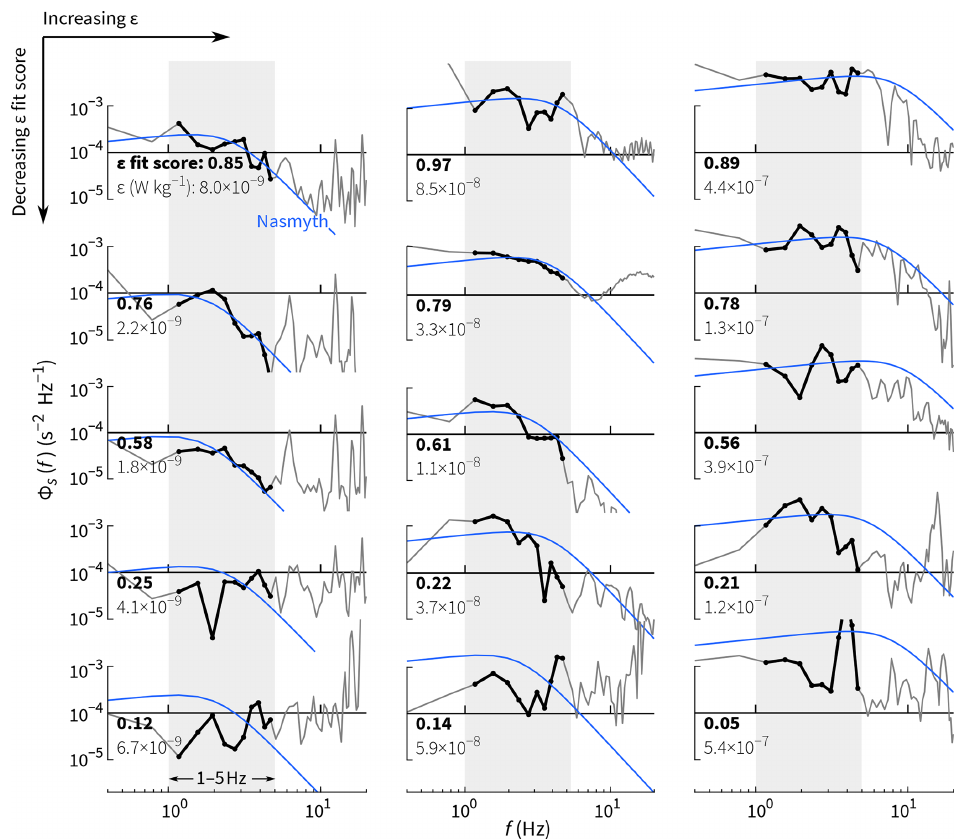
Figure 4. Examples of measured shear spectra exhibiting a range of (cid:15) fit scores (Eq. 26). The best fits are at the top with progressively worse fits (lower scores) moving downward. The examples in each column have (left) (cid:15) = 10 − 9 –10 − 8 , (middle) (cid:15) = 10 − 8 –10 − 7 , and (right) (cid:15) = 10 − 7 –10 − 6 Wkg − 1 . Each score is only based on spectral coefficients from 1–5Hz, but lower and higher frequencies are shown for